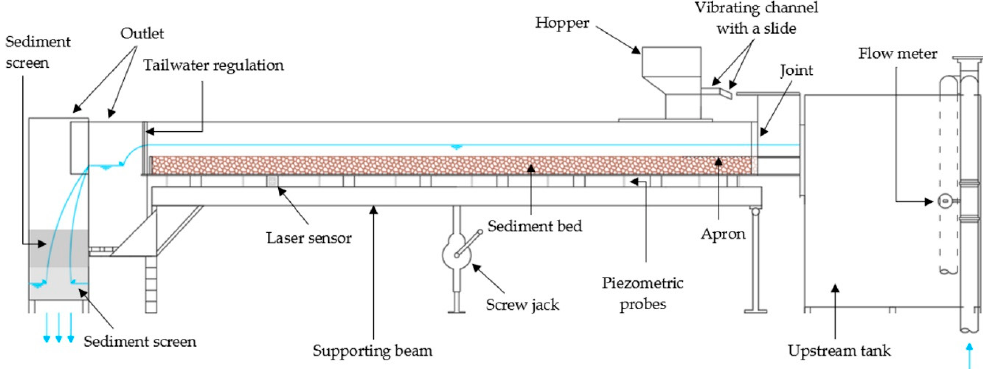
Figure 1. Schematic representation of the laboratory facility. 这个图的空白处可以在截点，有点多